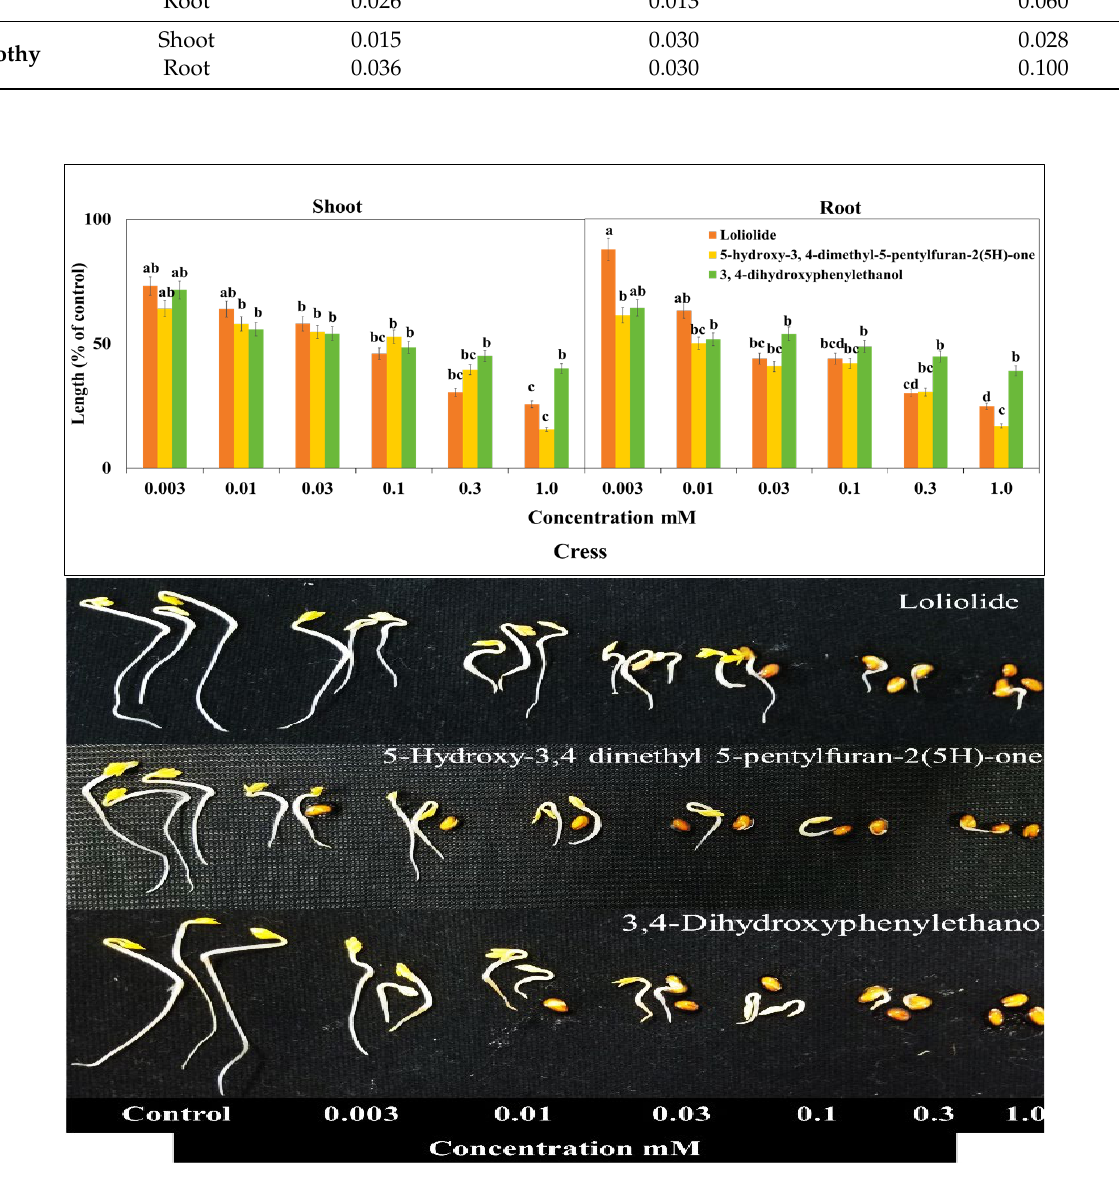
Figure 5. Effects of loliolide, 5-hydroxy-3,4-dimethyl-5-pentylfuran-2(5H)-one, and 3,4-dihydroxyphenylethanol treatment on the growth of cress seedlings. Mean ± SE of each experiment replicated 3 times ( n = 30). Differences between control and treatment are represented by different letters (Tukey’s HSD at p ≤ 0.05).